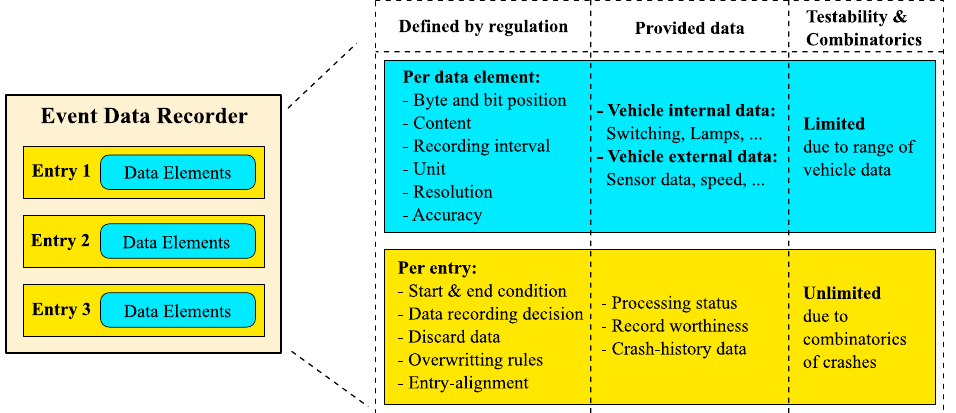
Figure 3. Details of data elements and event data recorder (EDR) entries.